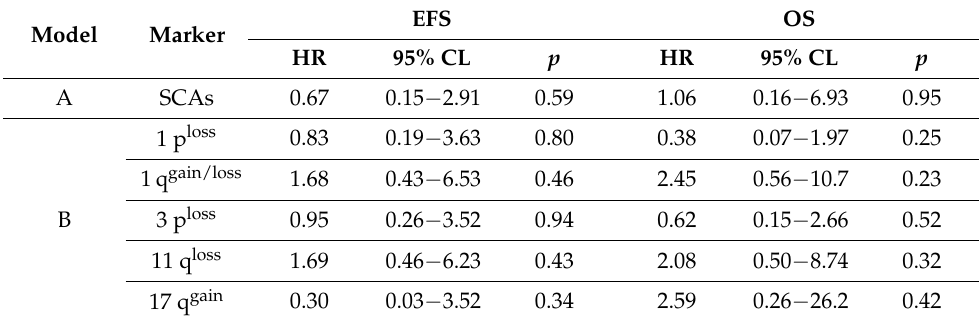
Table 4. Multivariate model of SCAs corrected by stage, age, and